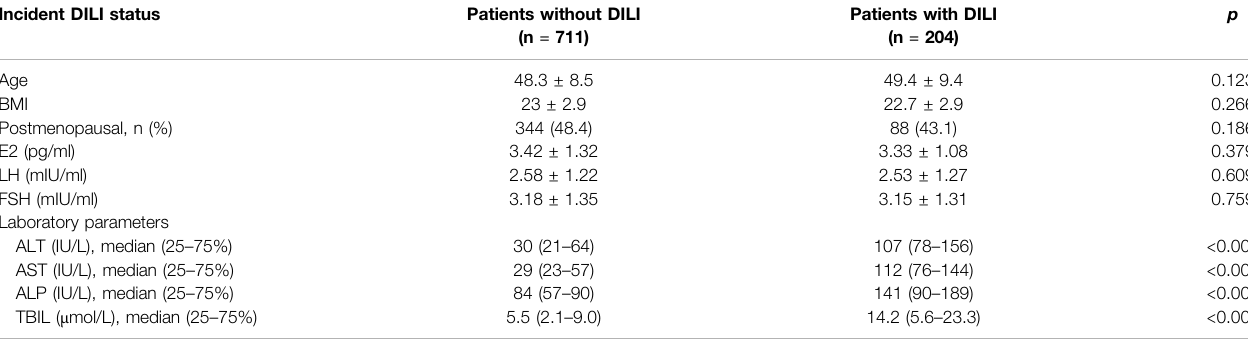
TABLE 1 | Characteristics of patients with and without drug-induced liver injury caused by chemotherapy.